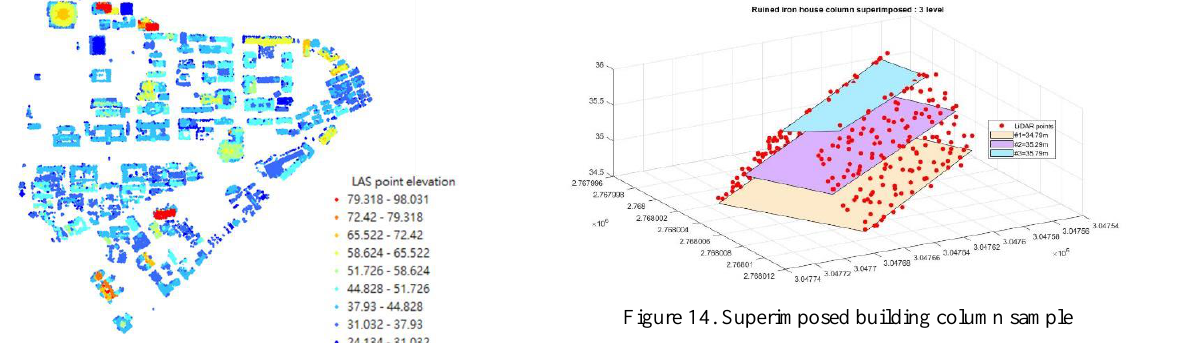
Figure 12. LiDAR points post-extraction